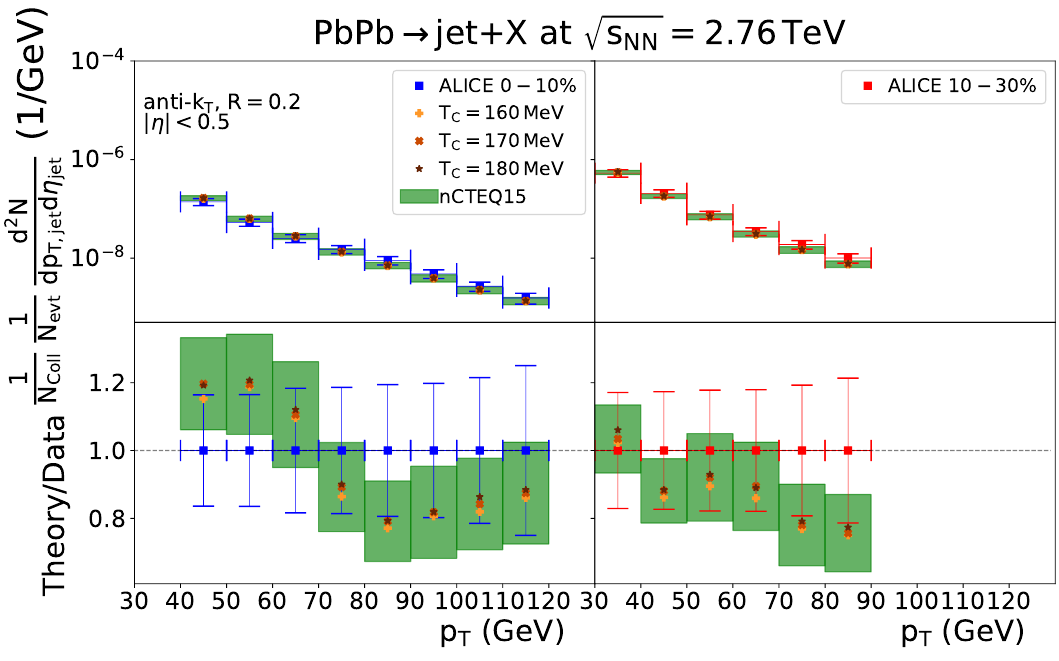
Figure 10 . Dependence of the jet yield on the critical temperature T C of the QGP. The default value in JEWEL for T is 170 MeV . The PDF uncertainties correspond to the green shaded C